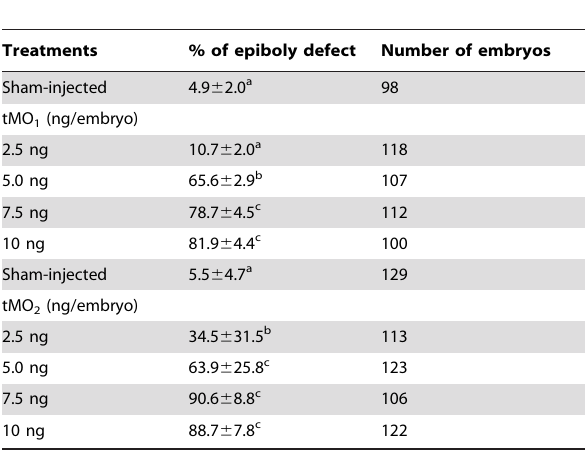
Table 1. Loss of Cfl1 dose-dependently causes epiboly